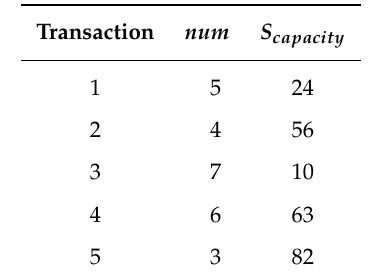
Table 1. The test transaction data published by